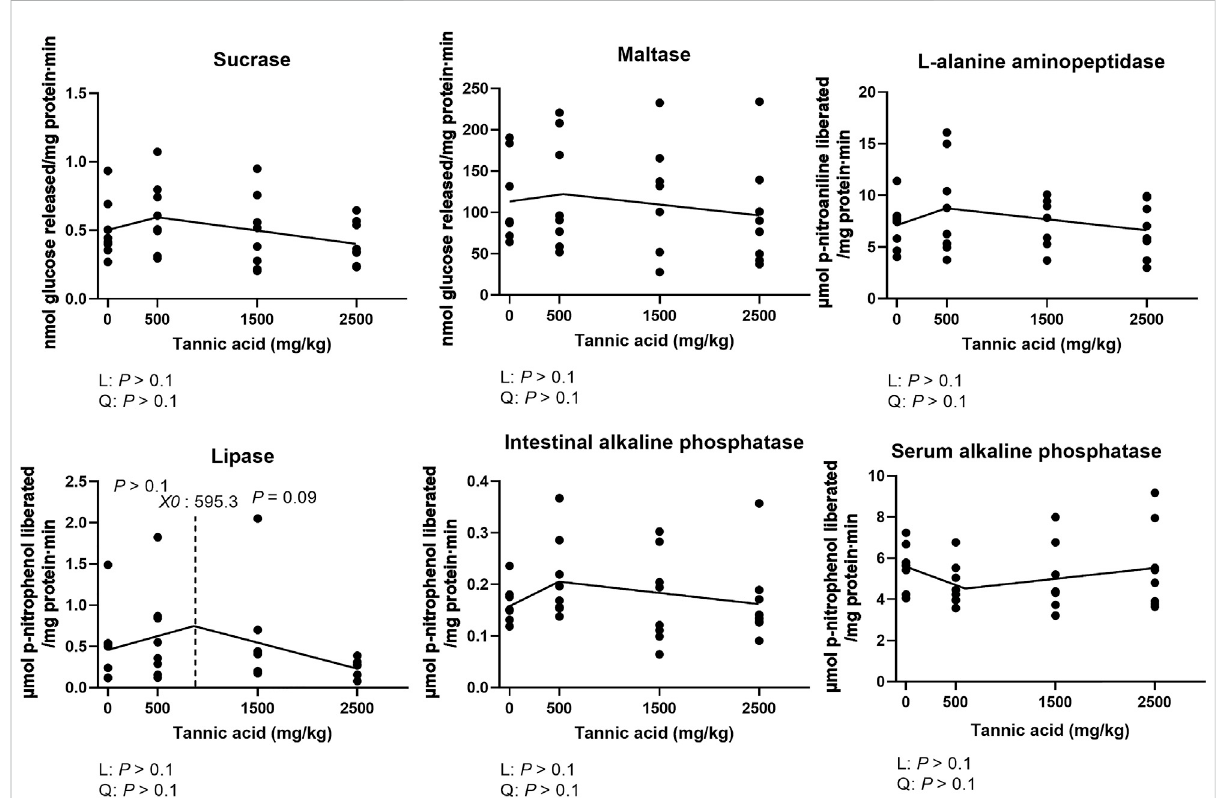
FIGURE 4 Activities of sucrase, maltase, L-alanine aminopeptidase, intestinal alkaline phosphatase, serum alkaline phosphatase lipase in the jejunum in broiler chickens fed different concentrations (0, 0.5, 1.5, and 2.5 g/kg) of tannic acid on D 21. The treatment groups were compared using one-way ANOVA followed by the Tukey ’ s multiple comparison. Different superscripts differ at p < 0.05. Orthogonal polynomial contrasts analysis was conducted to see linear pattern (L) and quadratic pattern (Q) among the treatments. To calculate the optimal dosage of tannic acid in broilers, segmented linear regression was conducted, and X0 (in fl ection point) with p values for slope 1 (lower than X0 ) and slope 2 (higher than X0 ) were